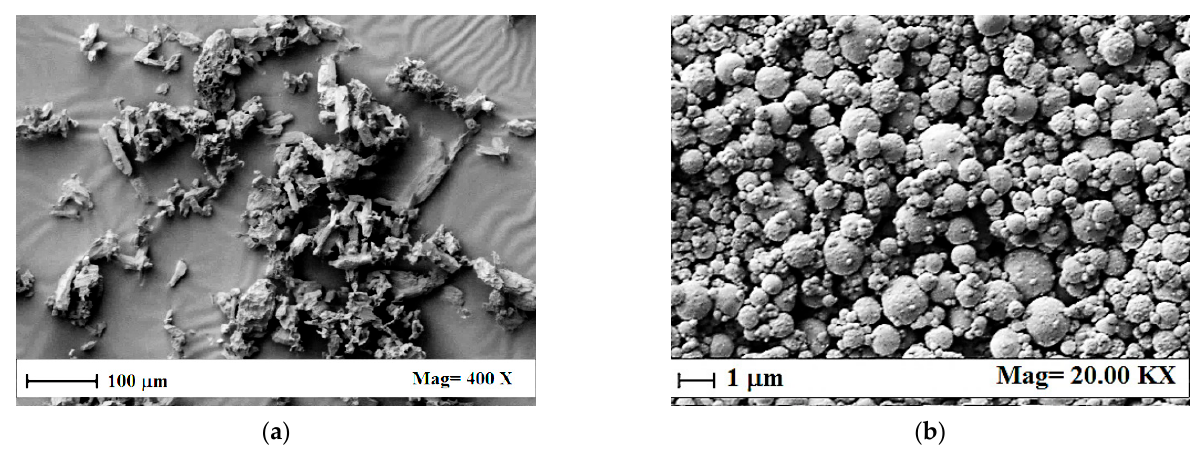
Figure 4. SEM images of ( a ) untreated salicylic acid powder and ( b ) sodium alginate-salicylic acid co-precipitated microparticles obtained via SAA at 80 °C, 82 bar, and GLR = 1.8. The loaded microparticles showed a larger mean diameter with respect to the so- dium alginate microparticles obtained at the same alginate concentration; in particular,